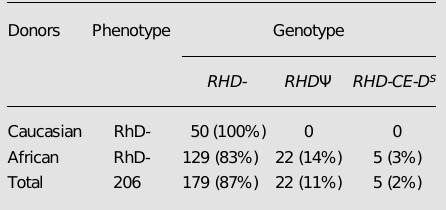
Figure 2. Multiplex PCR for de- tection of the RHD hybrid alle- les and the RHD Ψ . A , 8% acryl- amide gel showing results with multiplex PCR products ampli- fied with six RHD -specific primer sets (exons 3, 4, 5, 6, 7 and 9). B , 2% agarose gel show- ing results with multiplex PCR for predicting D and C/c pheno- type and for detecting the pres- ence of RHD Ψ .